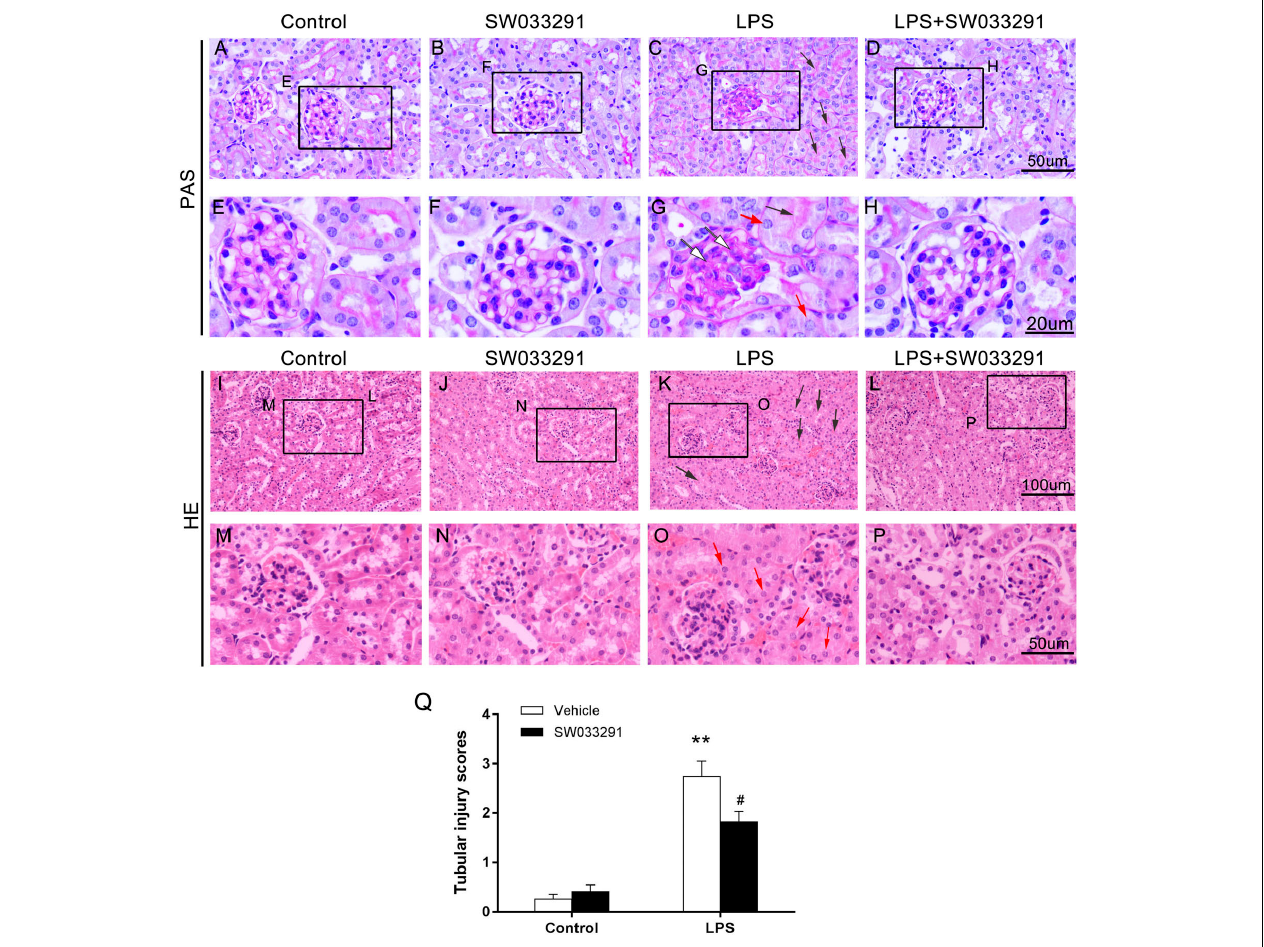
FIGURE 4 | Effect of SW033291 treatment on renal morphologic changes of AKI mice induced by LPS. (A–D) PAS staining (12 h) (400 × ); (E–H) Partial enlargement of PAS staining; ( n = 3) (I–L) HE staining (12 h) (200 × ); (M–P) Partial enlargement of HE staining. ( n = 3) The red arrow ([QSIImage]) indicates renal tubular epithelial cell edema; the black arrow ([QSIImage]) indicates tubular lumen shrinkage; the white arrow ([QSIImage]) indicates hyperplastic glomerular mesangial and thickened basement membrane. (Q) Shows the kidney tubular injury scores in mice with LPS-induced AKI after SW033291 (10 mg/kg) treatment, as described in section Materials and Methods ( n = 3). ** P < 0.01 (compared with control group); # P < 0.05 (compared with LPS group). Data are mean ±